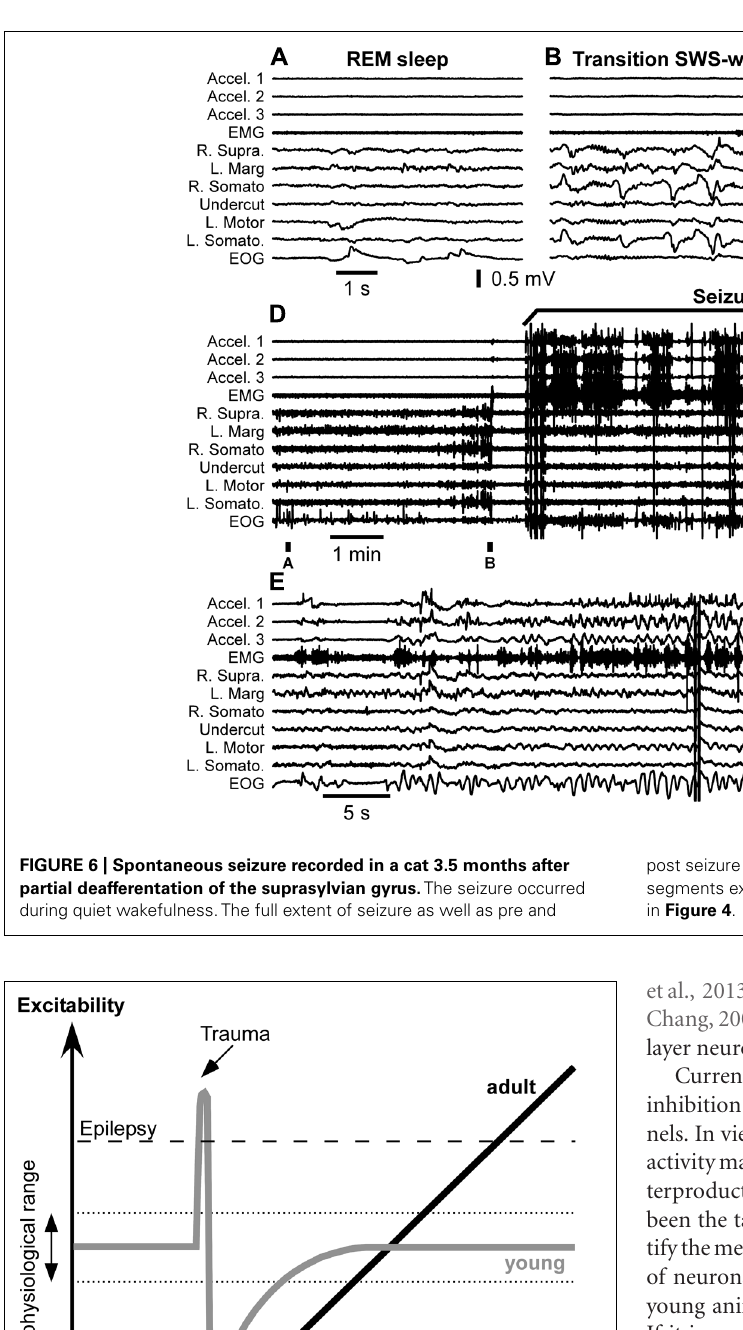
FIGURE 7 | Proposed dynamics of network excitability induced by brain trauma in young and adult subjects.